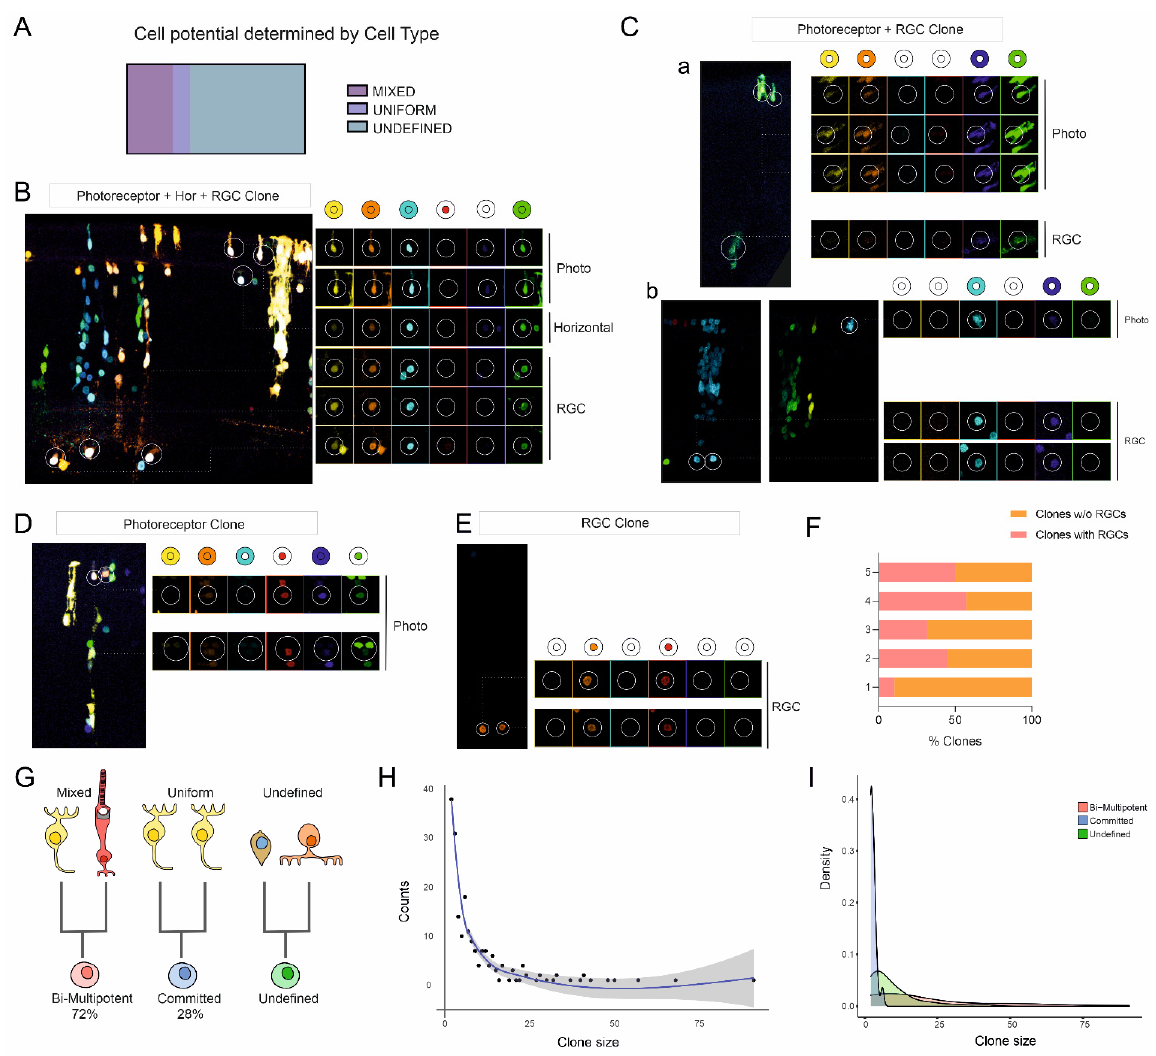
Figure 4. Progenitor potential and clonal heterogeneity deciphered using UbC-StarTrack. ( A ) Schematic representation of the proportions of clones according to their cell type composition: mixed clones included at least two differentiated cell types, uniform clones only one and undefined clones were composed by cells for which an identity could not be designated. ( B ) A mixed clone was formed through three differentiated cell types: two photoreceptors, a horizontal cell and three RGCs. ( C ) Examples of mixed clones formed by both photoreceptors and RGC. Sibling cells could appear in the same horizontal retinal slice (a) or in adjacent ones (b). ( D , E ) Uniform clones were those composed by only one differentiated cell type, as photoreceptors ( D ) or RGCs ( E ). Cells from each clone are circled at each image. For all cells, the details of the XFPs expression is shown. Clone color codes are represented by the schematics. ( F ) Proportion of the clones that included RGCs in the five analyzed replicates. ( G ) Schematics displaying the progenitor potential deciphered by the clone composition. Mixed clones were derived from bi- or multipotent progenitors, whereas uniform clones arose from committed progenitors at E3.5 (HH21-22). There was a proportion of clones for which progenitor potential was not assessed due to the presence of sibling cells within the clone for which cell identity could not be found at the time of the analysis at E11.5-12 (HH38). ( H ) Scatterplot showing the accumulation of clones, named counts, of a determined size. Blue line shows the predicted fitting by local polynomial regression, and the grey shadow represents the standard error of the predicted model when using a 0.95 confidence interval. ( I ) Density chart comparing the distribution of the clonal sizes at E11.5-12, depending on the nature of the E3.5 RPCs: bi-multipotent, committed or